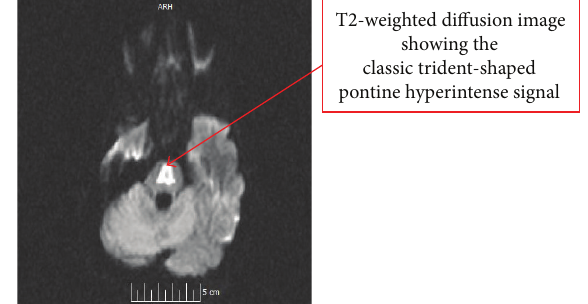
Figure 1: Initial MRI of brain.